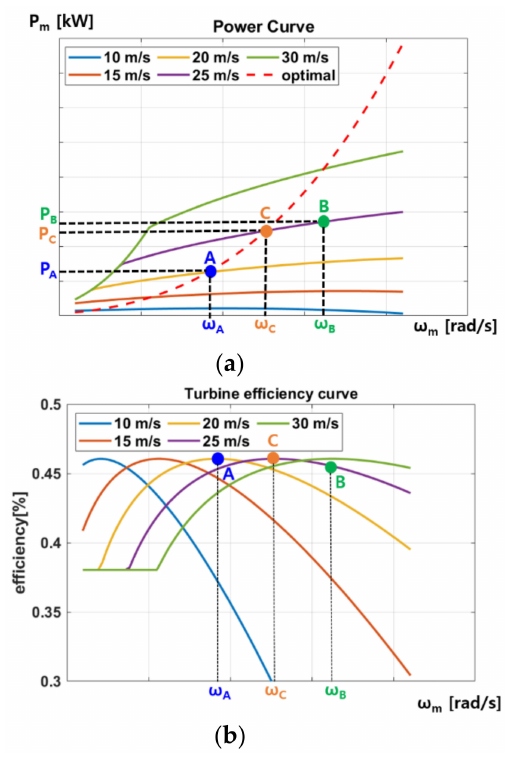
Figure 8. ( a ) Angular velocity and mechanical output characteristic curve according to flow velocity; ( b ) Angular velocity and turbine e ffi ciency.